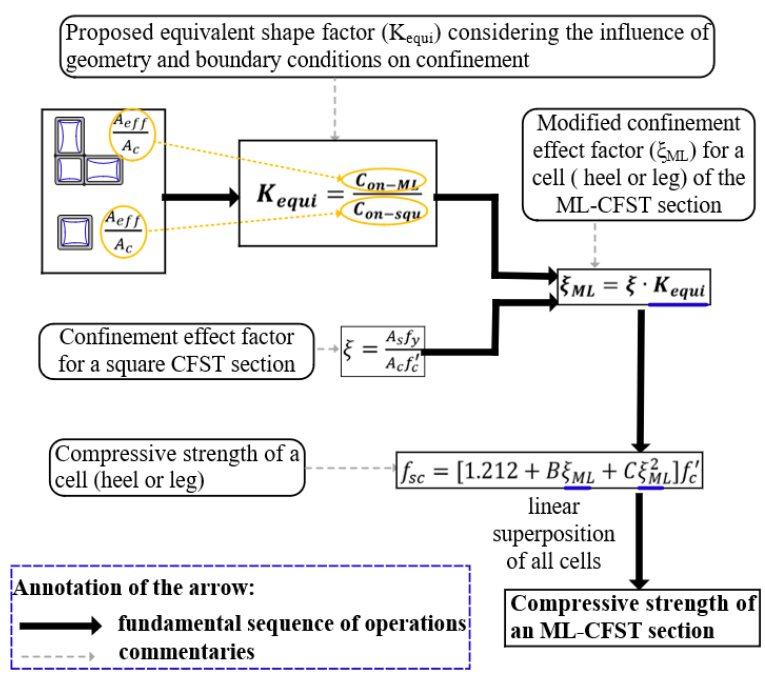
Figure 3. The development of a formula applicable to determining the compressive strength (f sc ) of an ML-CFST section.